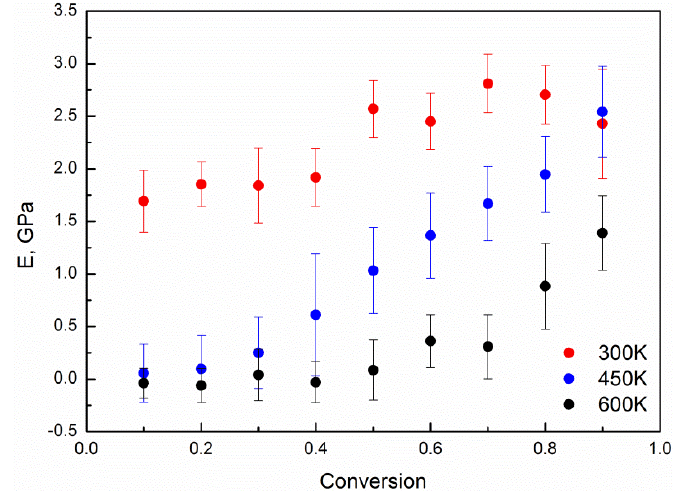
Figure 4. The Young’s modulus of systems at temperatures T = 300 K, 450 K, and 600 K, deformed with a rate of 5 ∙ 10 − 5 nm/ps along the Z direction, as a function of the conversion degree.